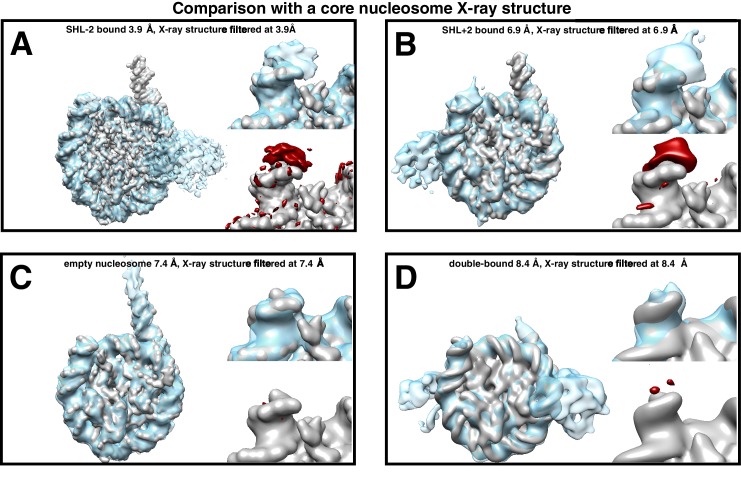
Difference maps to test for extra density of DNA at exit side of SNF2h-nucleosome complexes.(A–C) Cryo-EM density map of the nucleosome either with SNF2h bound at (A) SHL-2 and (B) SHL+2 with 140 mM KCl with the simulated density map of nucleosome without two additional base-pairs filtered to a common resolution (A: 3.9 Å, B: 6.9 Å). (C) Cryo-EM density map of nucleosome without added SNF2h with the simulated density map of nucleosome without two additional base-pairs filtered to a common resolution (7.4 Å). For A–C), left: each panel shows an overview of the EM density (light blue) overlaid onto the simulated nucleosome map. Top right: enlarged view centered on the DNA exit site. Bottom right: enlarged view of the DNA exit site showing the difference density between the simulated map and the EM density at σ = 7. (D) Left: cryo-EM density map of doubly-bound nucleosome with 70 mM KCl is overlaid with the cryo-EM density map of the simulated nucleosome map. Both maps are filtered to a resolution of 8.4 Å. Top right: an enlarged view of the DNA end. Bottom right: density map of nucleosome alone is overlaid with the difference density calculated between the two, and visualized at σ = 7.